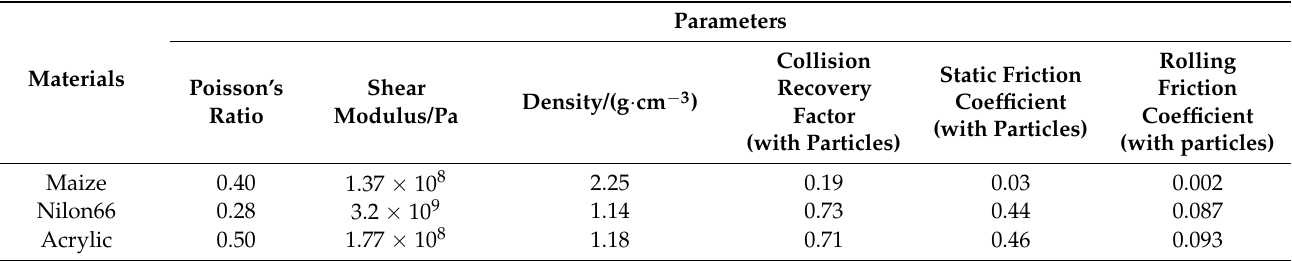
Table 4. Parameter settings for EDEM-CFD simulation of the maize seed meter.